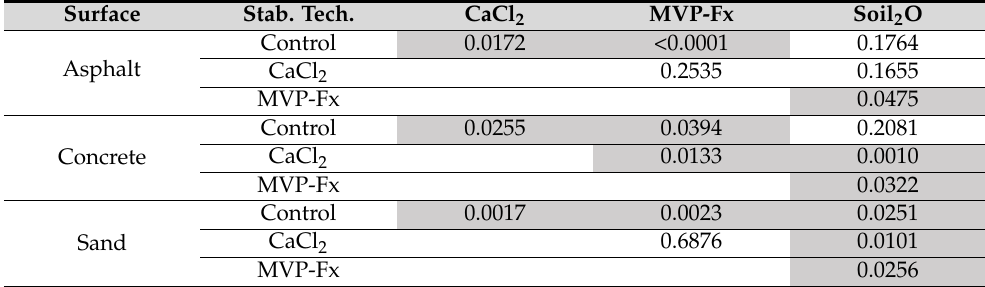
Figure 10. Percent Removal of Sr-85 Contaminated Particles for Vehicle Experiments. Table 4. Statistical results ( p -values) for simulated vehicle experiments percent removal. Gray shading indicates a significant difference ( p <